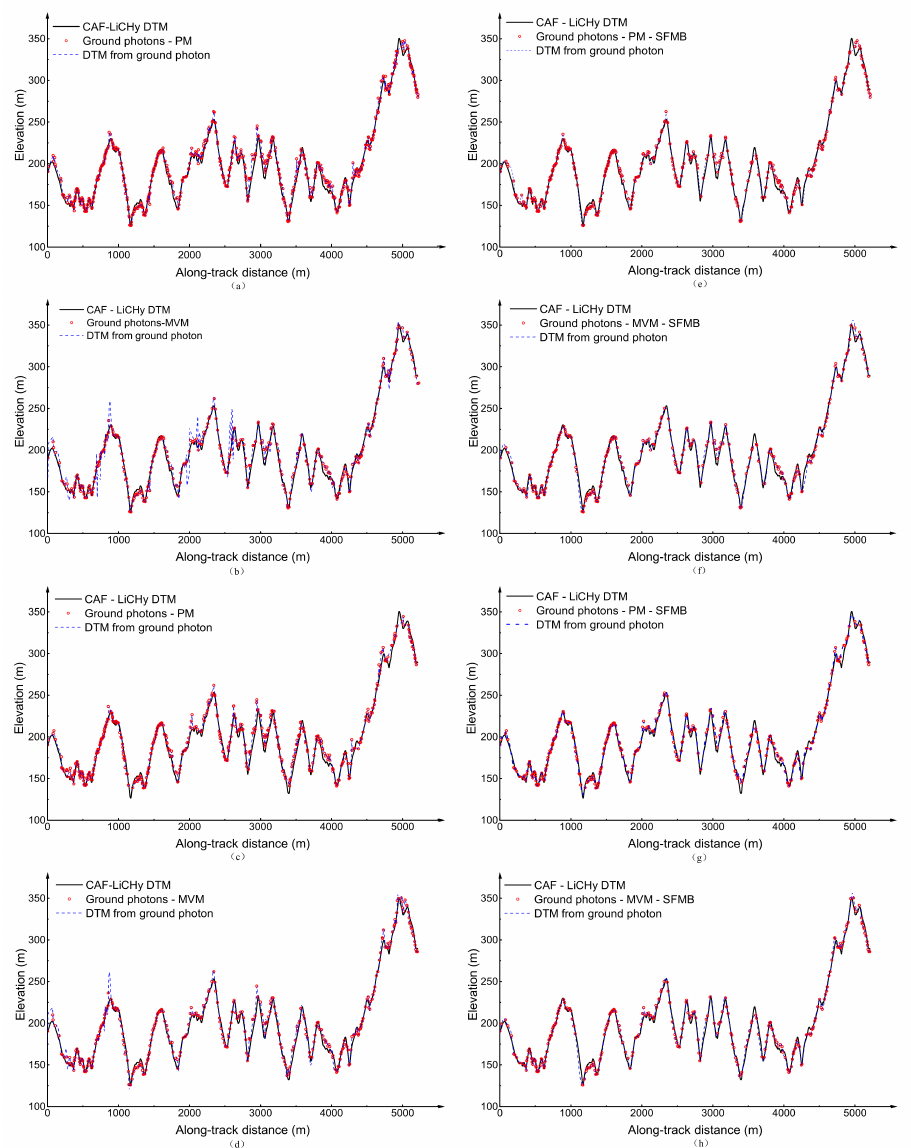
Figure 12. Ground points extracted from ATL03 initial photons and corrected photons using different methods. ( a ) Ground photons obtained using PM based on the ATL03 initial data; ( b ) ground photons obtained using MVM based on the ATL03 initial data; ( c ) ground photons obtained using PM based on the ATL03 corrected data; ( d ) ground photons obtained using MVM based on the ATL03 corrected data; ( e ) ground photons obtained using PM based on the initial ATL03 data and then filtered by SFMB; ( f ) ground photons obtained using MVM based on the initial ATL03 data and then filtered by SFMB; ( g ) ground photons obtained using PM based on the corrected ATL03 data and then filtered by SFMB; ( h ) result of ground photons based on ATL03 correction data using MVM and then filtered by